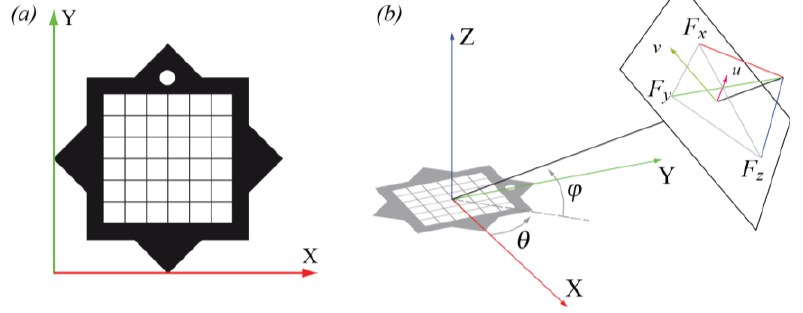
Figure 1. The structure of our marker ( a ) and the relative position of camera and marker ( b